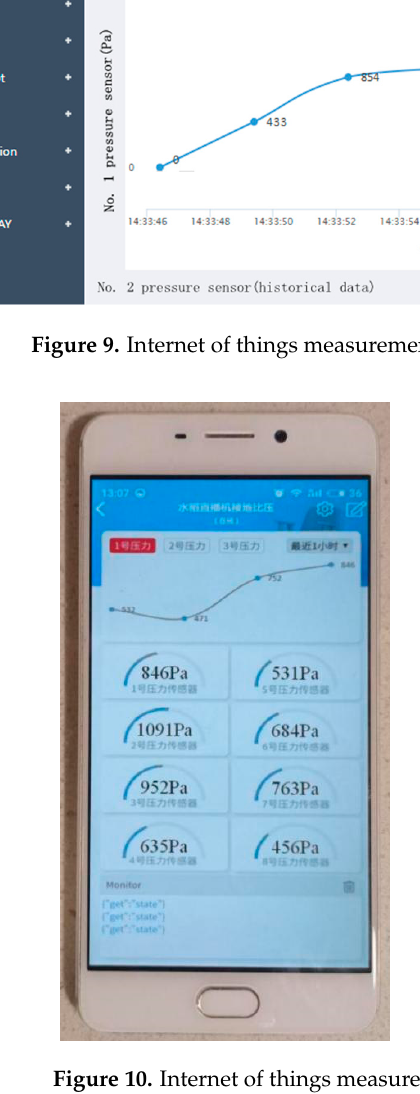
Figure 10. Internet of things measurement system—mobile terminal.